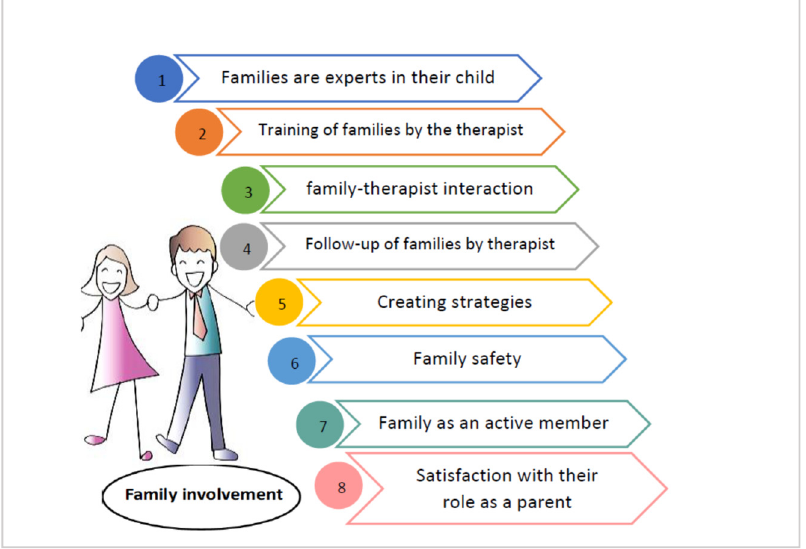
Figure 3. Components that should be included in family involvement in UCP early intervention.